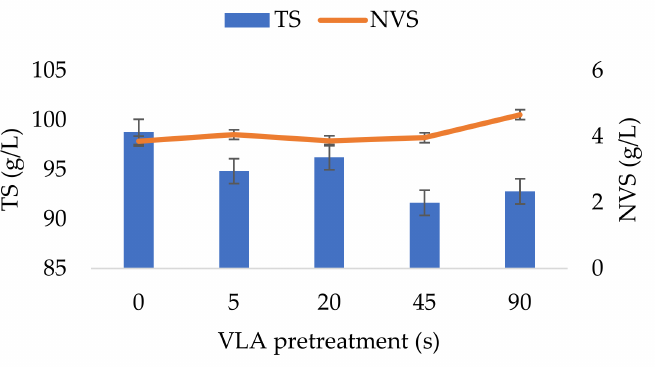
Figure 2. Change in the content of total and non-volatile solids depending on the pretreatment time. Pretreatment in VLA contributed to a sharp increase in the ethanol content (Figure 3). The ethanol content compared to untreated CW after 45 and 90 s of pretreatment increased by 38.46 and 75.77%. The concentration of acetate after 5 and 20 s of pretreatment decreased, while after 45 and 90 s of pretreatment increased by 12.77% and 43.62%. The content of butyrate decreased by half after 5 s of pretreatment and did not change with increasing pretreatment time. The content of propionate increased after 5 s, 45 s and 90 s by 25%, 25% and 50%, while after 20 s it decreased by 8.33%. It should be noted that the 20 s pretreatment was less pronounced: the content of ethanol and acetate decreased by 8.97% and 24.47%, respectively, which correlates with the smallest decrease in the ratio of TS/VS by 0.11% and COD by 3.43%. Interestingly, the pH of CW after pretreatment in VLA increased, despite the increase in the content of VFAs.